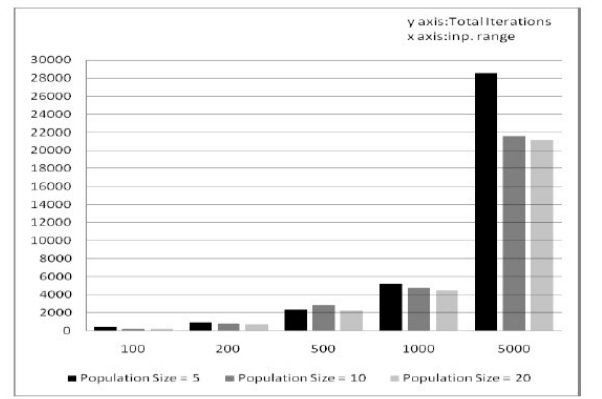
Figure 6. Total iterations vs. input